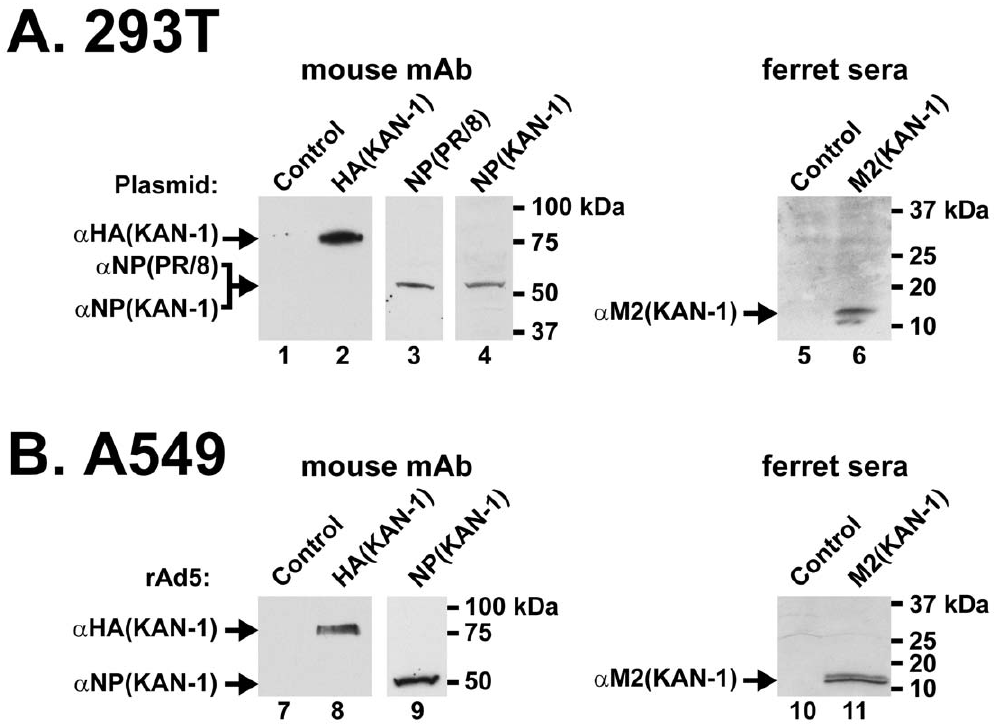
Figure 1. Expression of immunogens using DNA and rAd5 vectors in cell culture. (A) Western blot analysis confirmed the expression of HA protein of A/Thailand/1/KAN-1/2004 (lane 2), NP protein of A/PR/8/34 (lane 3) and A/Thailand/1/KAN-1/2004 (lane 4), and M2 protein of A/Thailand/1/ KAN-1/2004 (lane 6) in 293T cells transfected by eukaryotic plasmid expression vectors. (B) Expression of rAd5 vectors was confirmed in A549 cells after transduction with vectors encoding HA (KAN-1) (lane 8), NP (KAN-1) (lane 9), and M2 (KAN-1) (lane 11). Arrows indicate the relevant predicted size of the indicated viral proteins. Bands refer to the right predicted size of different viral proteins that were detected in each lane as indicated. Molecular weight markers were used for protein size